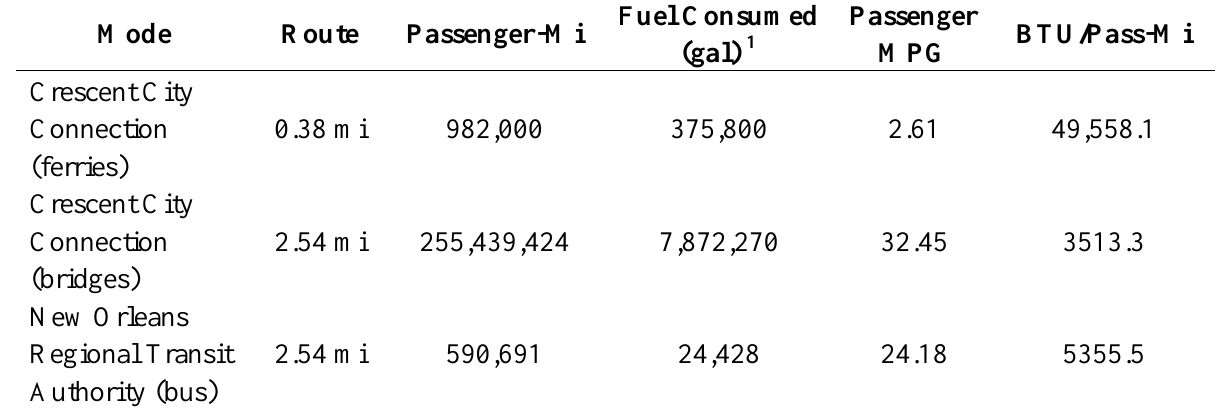
Table 4. Year 2008 Crescent City Connection and New Orleans Regional Transit Authority